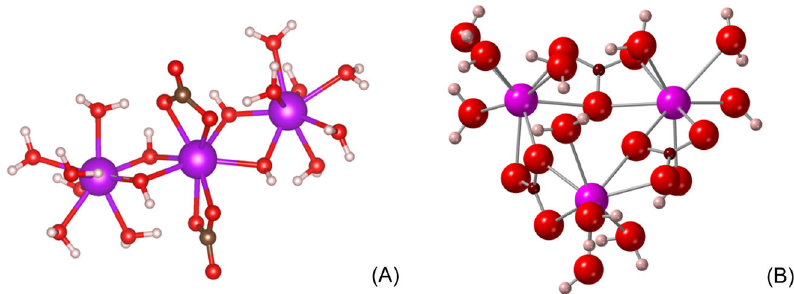
Fig. 4 Proposed structures for the Gd (hydroxyl-)carbonate complexes. Structures were obtained by static quantum mechanical calculations using the Amsterdam Density Functional (ADF) program: A [REE 3 (CO 3 ) 2 (OH) 4 (H 2 O) 12 ] + , B [REE 3 (CO 3 ) 3 (H 2 O) 12 ] 3 + . The atoms are gadolinium (purple), oxygen (red), carbon (brown), and